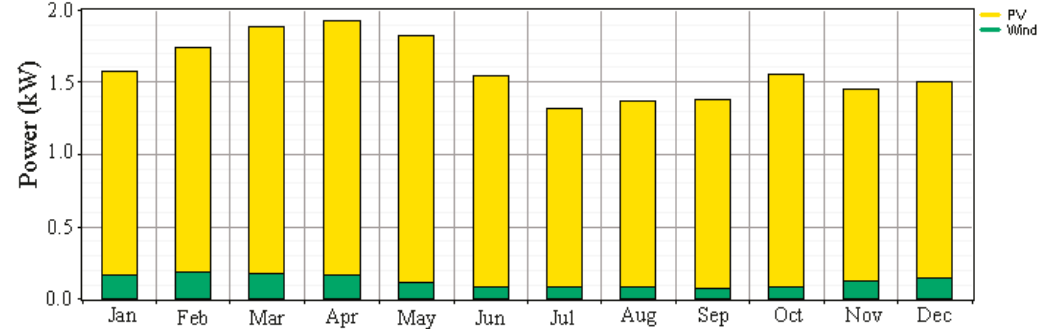
Figure 15. Monthly power contribution of various sources at an average solar irradiation